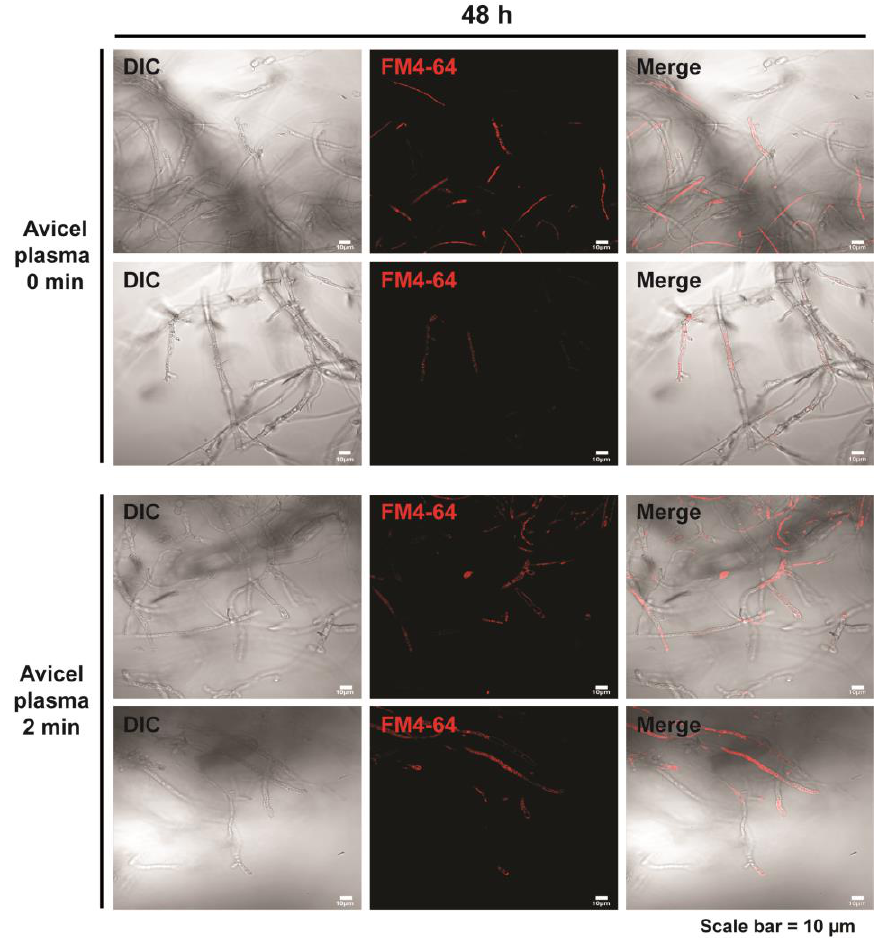
Figure 5. The vesicles in the fungal hyphae stained with FM4-64 48 h after plasma treatment. Fungal hyphae were treated in media containing Avicel with a plasma jet for 0 min or 2 min. Hyphae not treated with a plasma jet were used as controls. Two replicate pictures in each treatment are presented.